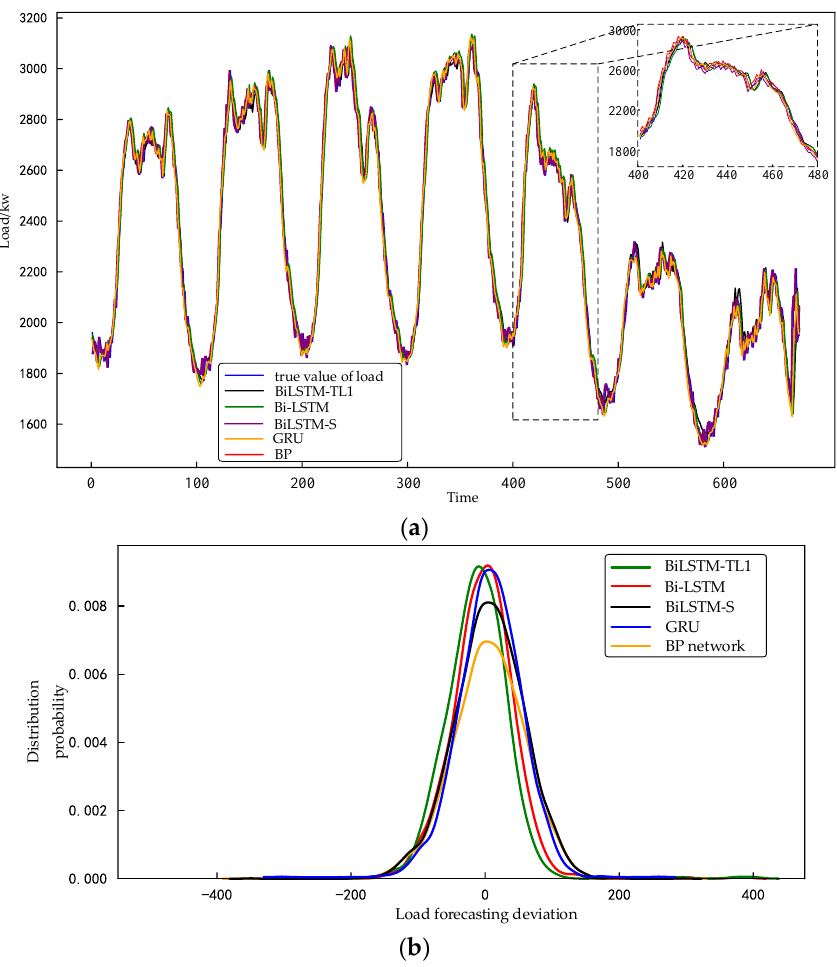
Figure 14. Comparison of prediction results of test set: ( a ) Comparison of prediction results of different model test sets; ( b ) Prediction error distribution curves of different model test sets.